Question: Give a one-sentence summary of this figure.
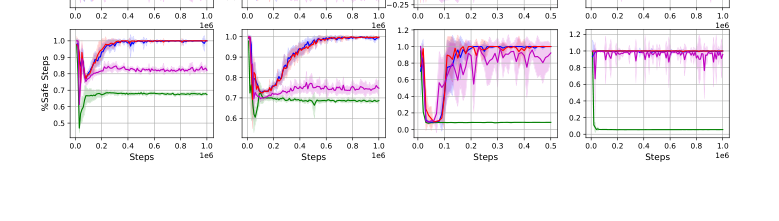
Answer: Bullet Safety Gym Results - Reward and Safety Performance